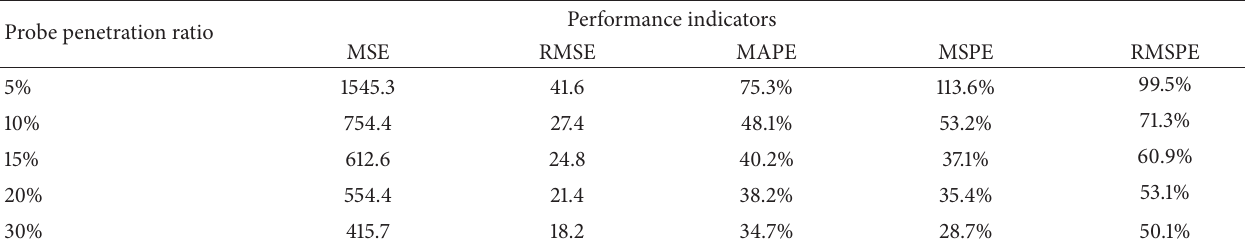
Table 6: Estimation accuracy of OD flows with different probe ratios.